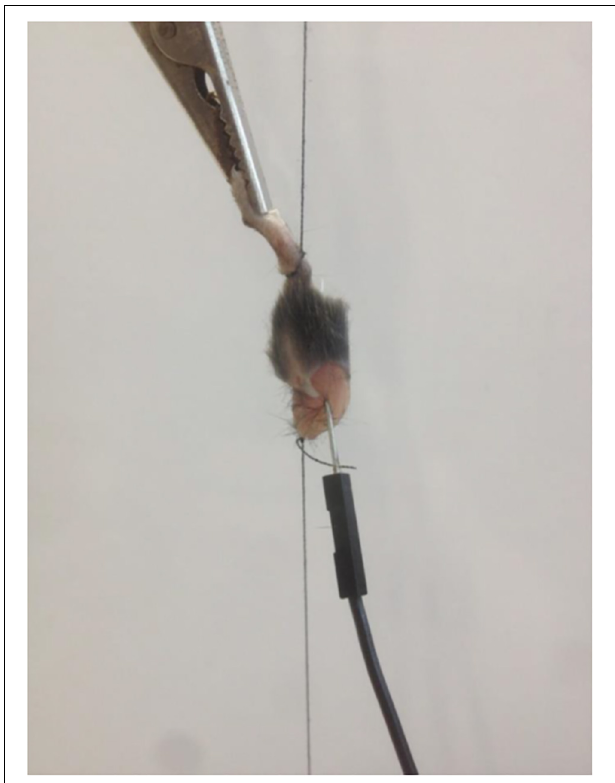
FIGURE 1 | Fixed mouse muscle with needle and clamp